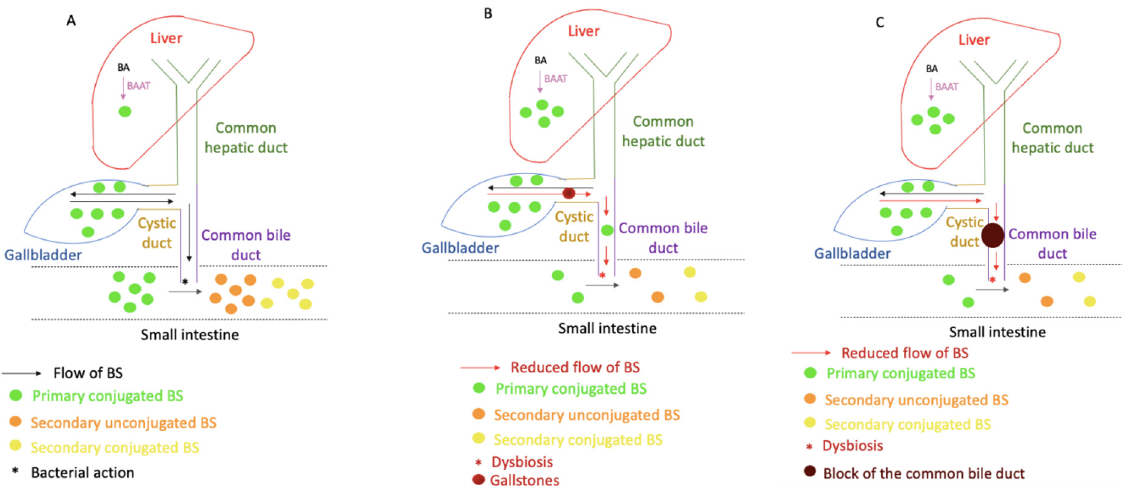
Figure 4. ( A ). The normal flow of the BSs from the liver, through the hepatic duct, cystic duct, gallbladder, and common bile duct to the small intestine. BSs are retransported back to the liver after fulfilling their role. They control their own synthesis by inducing expression of FXR. ( B ). As a result of gallstone formation, the flow of BSs is reduced. ( C ). Blockage of the BS flow caused by the development of cholangiocarcinoma. Decreased levels of reabsorbed BSs reduce the FXR signalling and promote activation of CYP7A1 enzyme leading to increased BA synthesis.